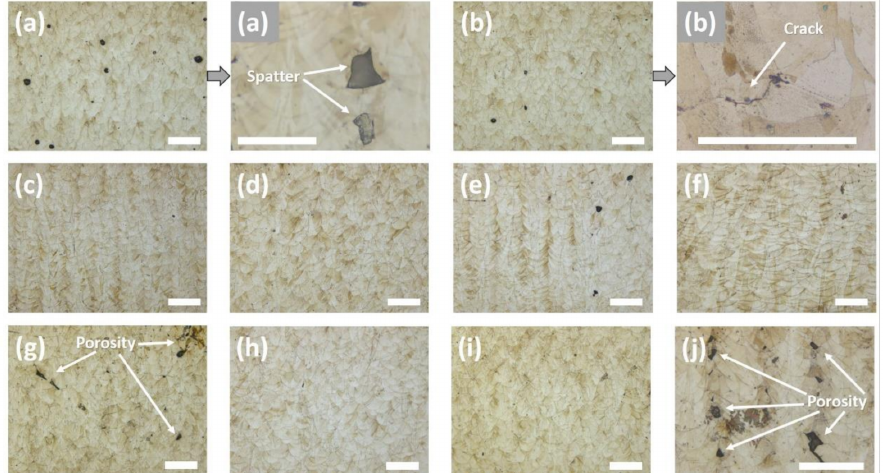
Figure 9. Optical micrographs of fabricated samples after etching. Black regions are defects, and the building direction is perpendicular to the plane. The optical micrographs are arranged from sample ( a ) to sample ( j ), respectively. Table 7 can be consulted for the production parameters of the samples (scale bar: 100 µ